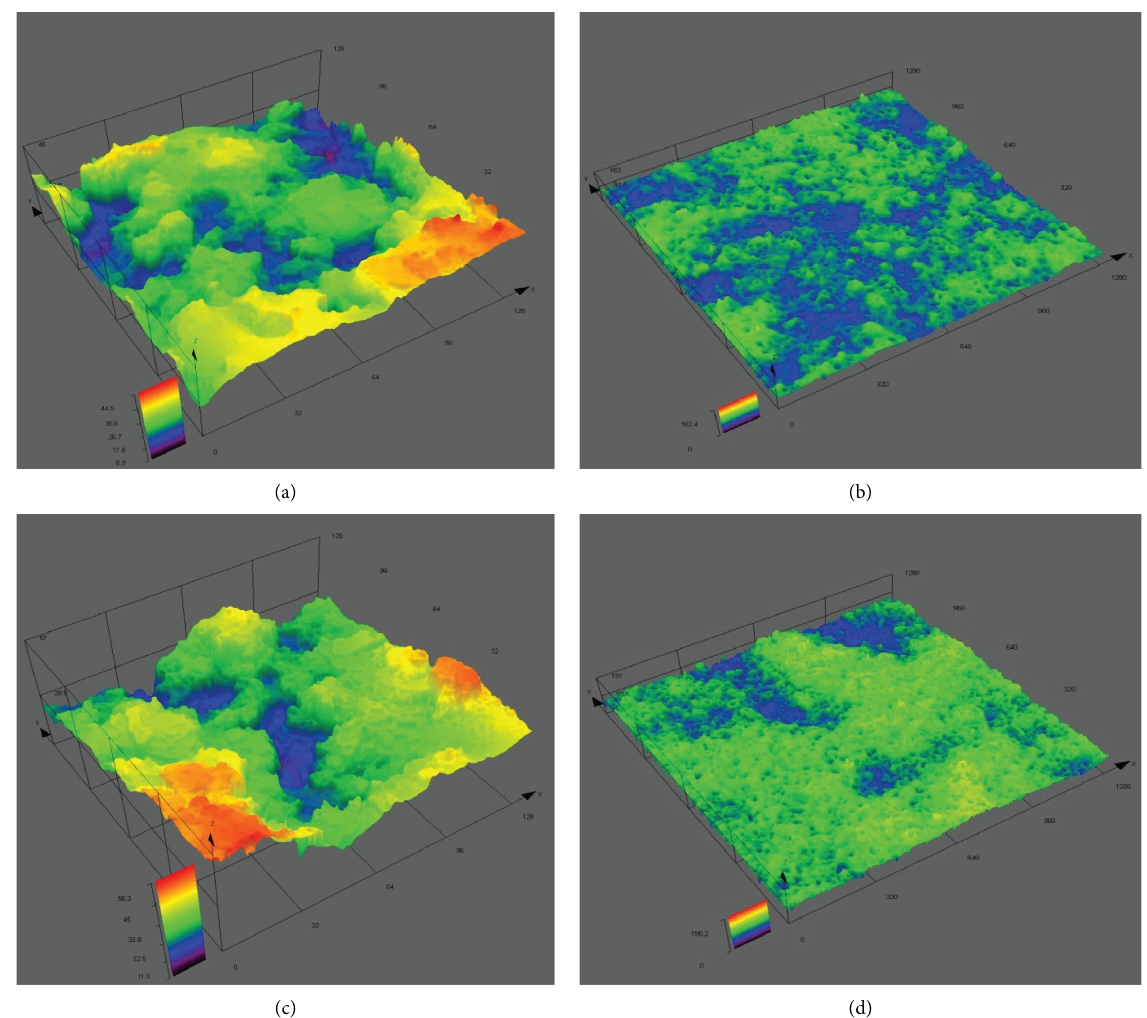
Figure 15: Confocal microstructures of slurry eroded surfaces at diferent particle sizes: (a) Al6061 alloy (210microns), (b) Al6061-WC+ Ni coating (210microns), (c) Al6061 alloy (625 microns) and (d) Al6061-WC+Ni coating (625